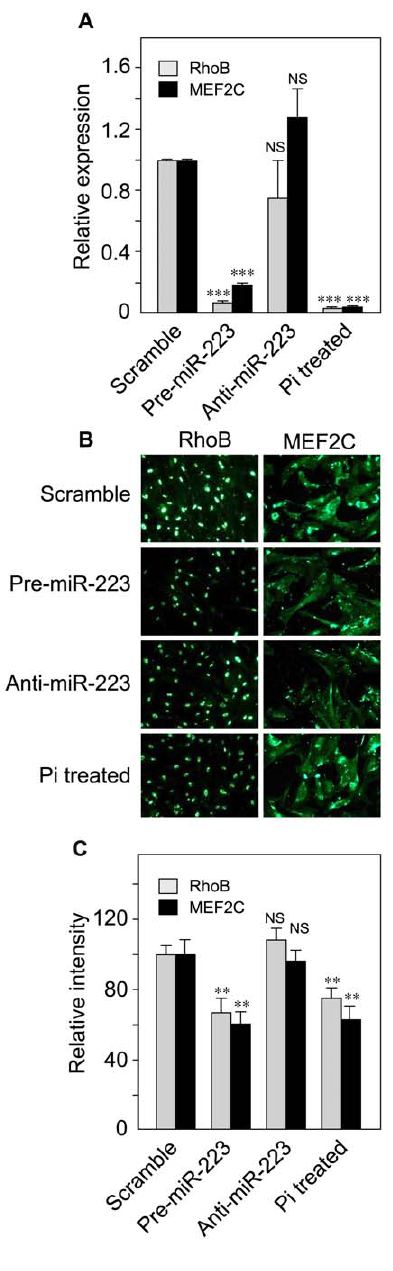
Figure 5. Effect of miR-223 up- and down regulation and Pi on miR-223 specific targets Mef2c and RhoB. To up-regulate and knock-down the expression of miR-223, VSMCs were transfected for 48 h with pre-miR223 and anti-miR-223, respectively. Scrambled, unrelated miRNA was used as a control. For Pi effect, VSMCs were cultured for 2 days in DMEM supplemented with 1% FBS, in the presence or absence of 3.5 mM Pi. (A) After RNA extraction, expression of Mef2c and RhoB messengers was measured by RT-qPCR. Data are represented as the mean of 3 independent experiments + / 2 SD). (B) Immunofluorescence images showing the effect of miR-223 up- and down regulation and Pi on Mef2c and RhoB protein expression in VSMCs (magnification 20X). (C) Fluorescence intensity measurements from the immunofluorescence images displayed in Figure 4B, showing the effect of miR-223 up- and down regulation and Pi on Mef2c and RhoB protein expression (n=3 for each marker, data are represented as the mean of 3 independent experiments + / 2